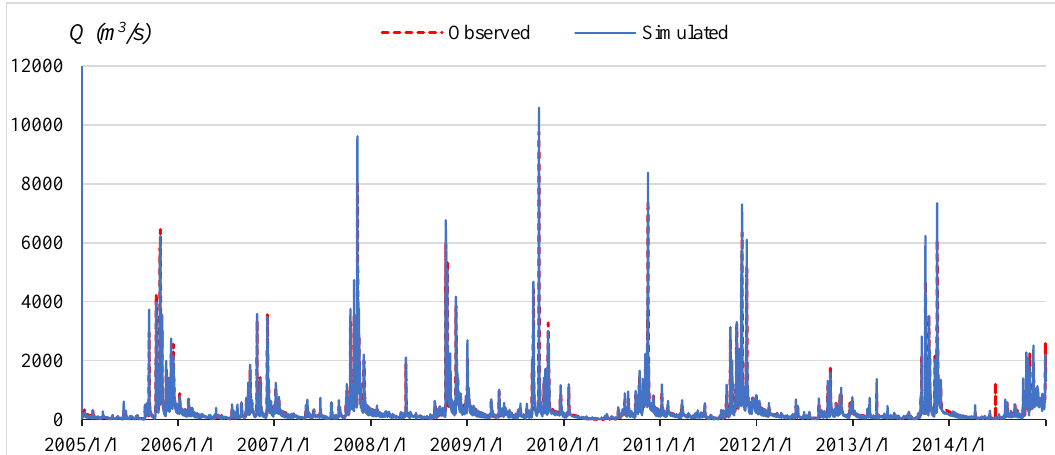
Figure 9. The calibration water discharge at the Nong Son hydrological station during 1995–2004.